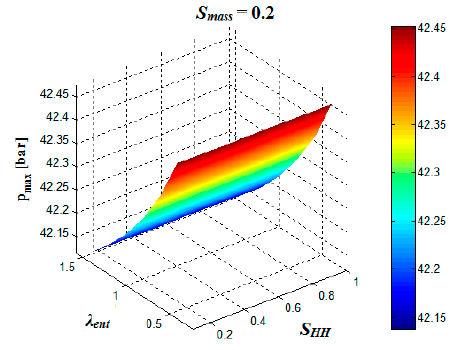
Figure 15. Peak pressure values when S mass is fixed.